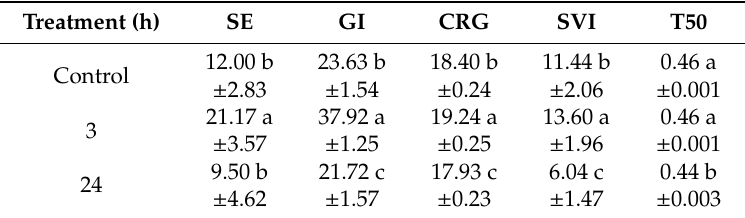
Table 2. Germination indexes of triticale ( × Triticosecale Wittm. ex A.Camus) grain irradiated with a helium-neon (He-Ne) laser by 3 and 24 h; mean ± SD (n = 10) values marked with di ff erent letters di ff er statistically according to Tukey’s test at p ≤